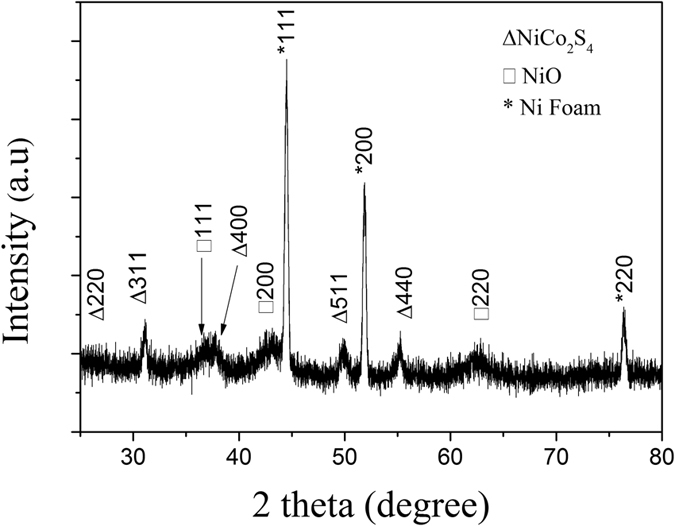
XRD pattern of the hierarchical NiCo2S4@NiO core-shell nanowires scratched from NiO foam.